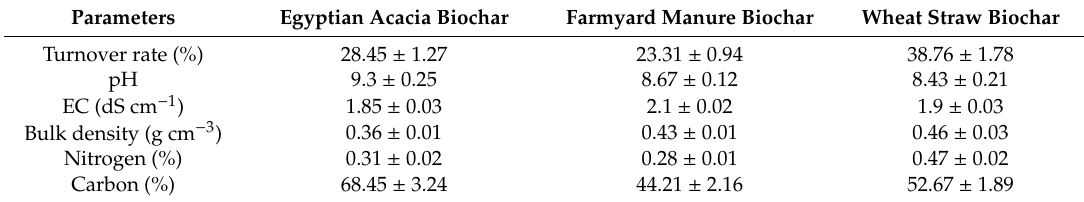
Table 1. Rate and physicochemical properties of biochar; values are the mean of three replications ±